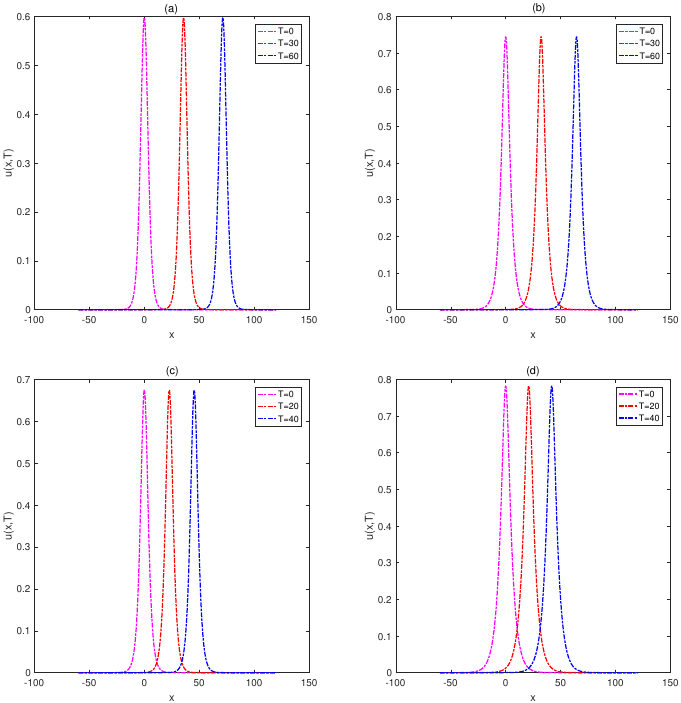
Figure 13. Motion of the single solitary wave for p = 3 ( a ), p = 6 ( b ) , p = 4 ( c ), and p = 8 ( d ) at final times T ∈ { 0,30,60 } ( a,b ) and T ∈ { 0,20,40 } ( c,d ) in the spatial interval x ∈ [ − 60,120 ] for Example 5. Table 9. The L ∞ and L 2 errors and the quantities Q and E with N = 360, n i = 295, c = 0.55 and τ = 0.1 in the spatial interval x ∈ [ − 60,120 ] for Example